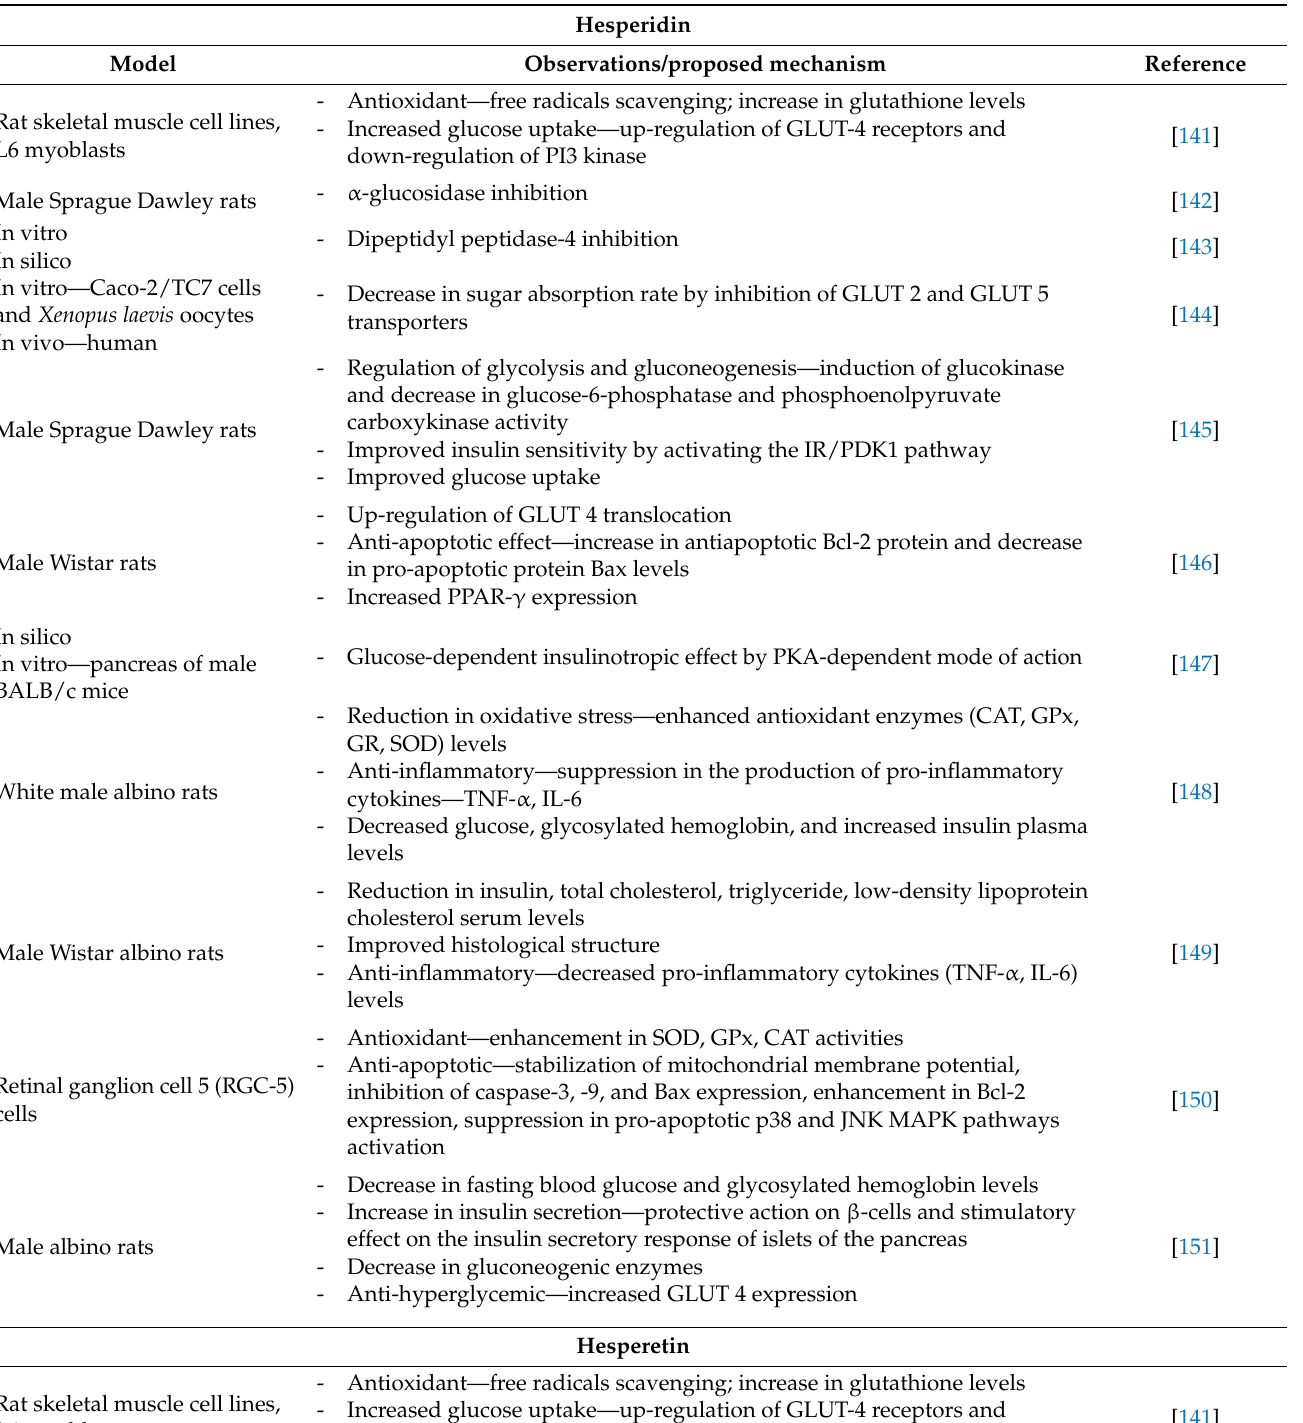
Table 3. Collected studies of pure compounds suggesting antidiabetic activity of hesperidin and